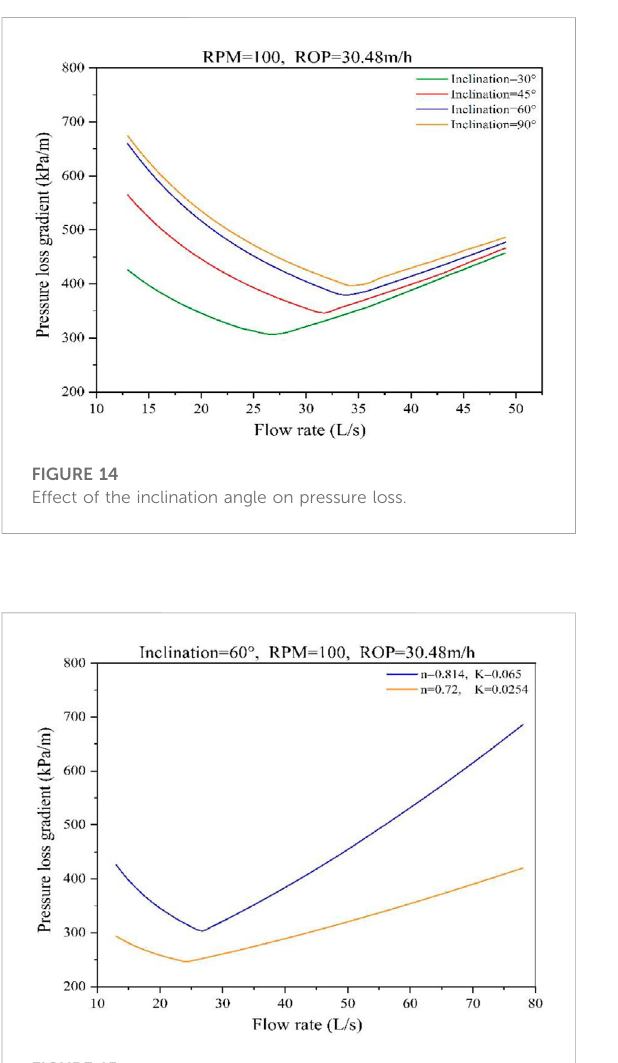
FIGURE 15 Effect of rheological parameters on pressure loss.